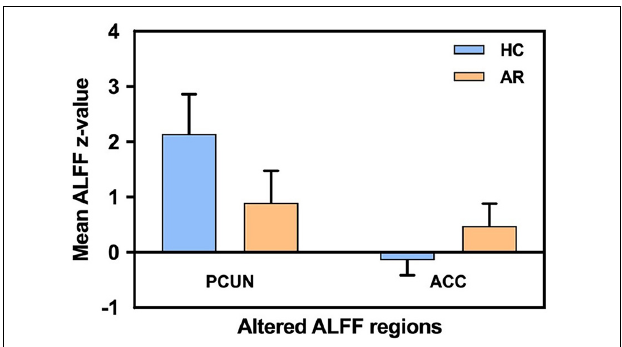
FIGURE 2 | Mean ALFF signal values for the altered regional brain areas between AR patients and HCs. ALFF, amplitude of low-frequency fluctuation; AR, allergic rhinitis; HCs, healthy controls; PCUN, precuneus; ACC, anterior cingulate cortex.